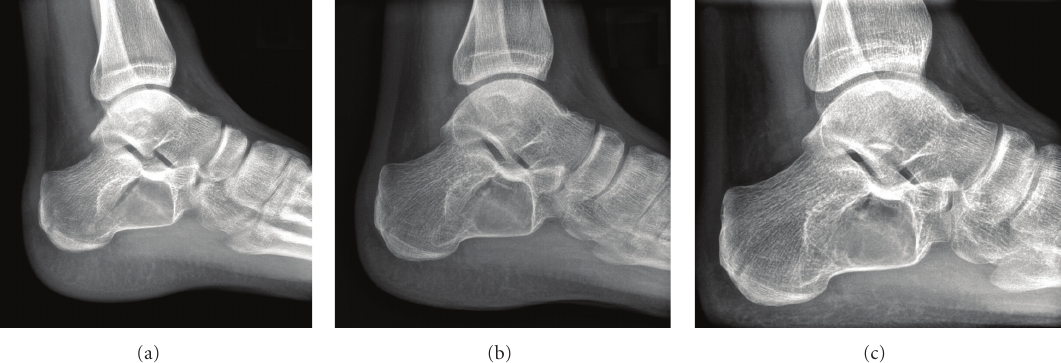
Figure 4: (a)Radiographic control 4 weeks after injury. (b)Radiographic control 8 weeks after injury. (c)Radiographic control 18 months after